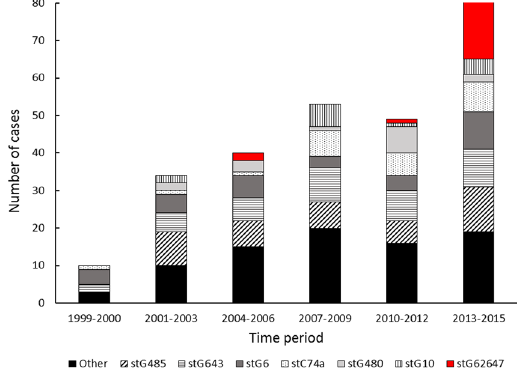
Figure 1. The temporal distribution of emm -types associated with 267 cases of invasive SDSE-disease encountered during 1999–2015. stG62647 was the predominant emm -type in the period 2013–2015, comprising approximately 20% of the invasive SDSE-isolates. The category “Other” includes stG166b (12), stG2078 (9), stG652 (8), stC5345 (4), stC36 (2), stC2574 (2), stC3852 (2), stG4831 (2), stG5420 (2), stC1400 (1), stC7901 (1), stG12 (1), stG120 (1), stG245 (1), stG4222 (1), stG507 (1), stG653 (1), stG6792 (1), stG840 (1) and 29 isolates not available for emm -typing.